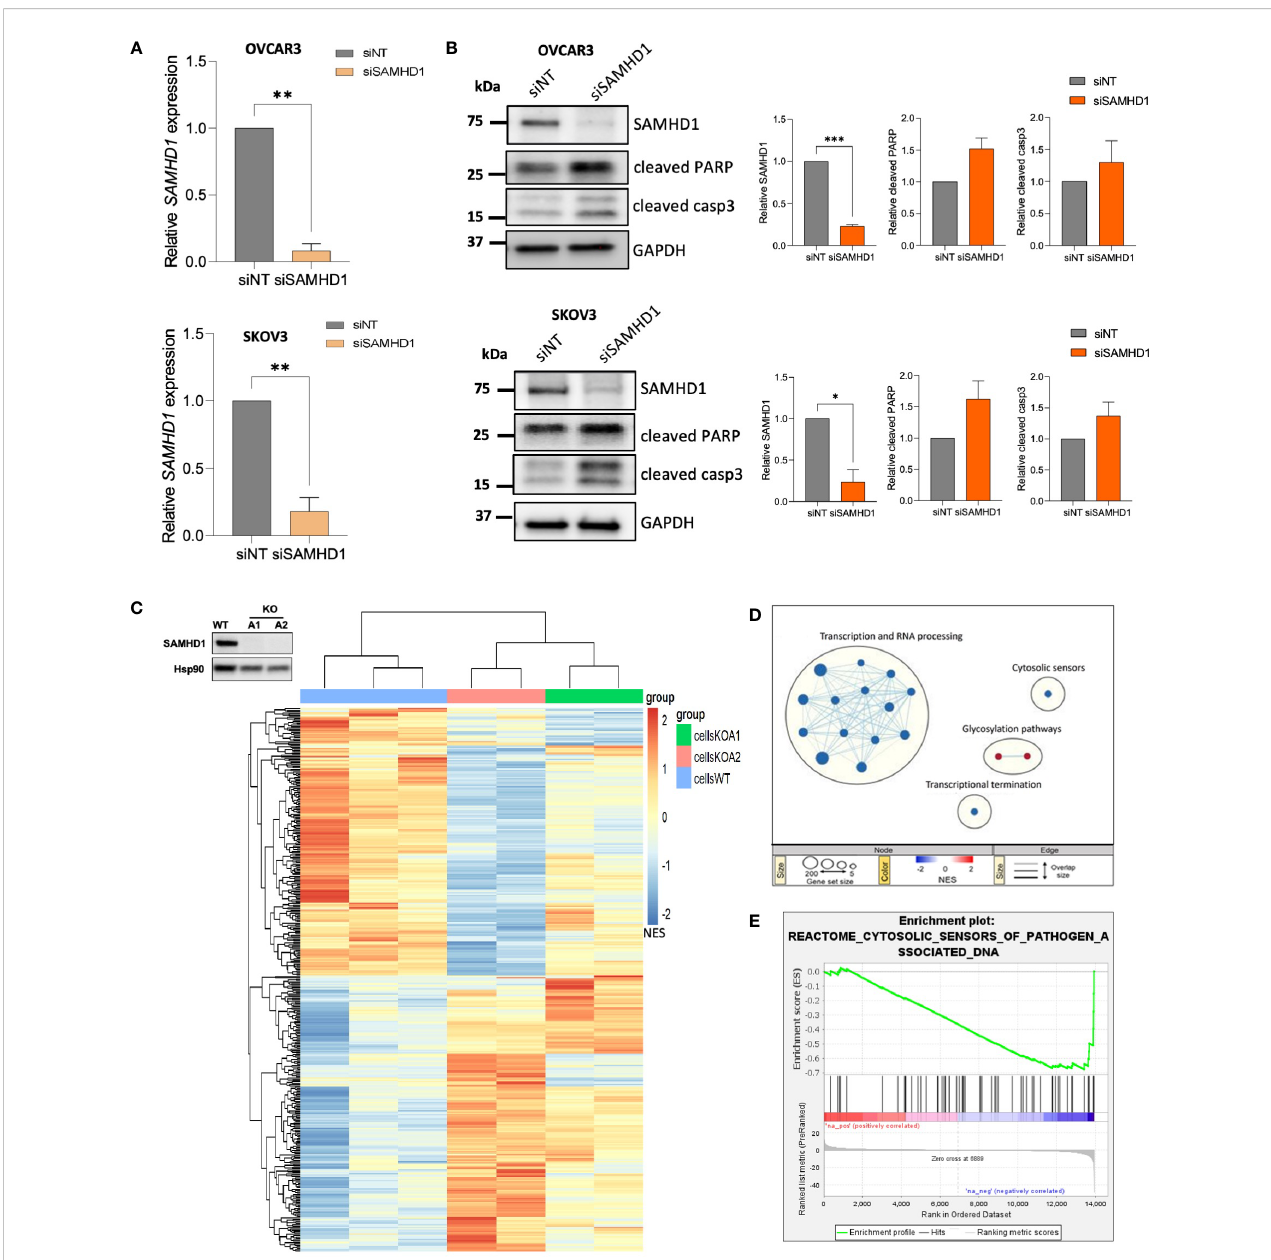
FIGURE 1 Depletion of SAMHD1 enhances apoptosis and regulates innate immune response. (A) Effective SAMHD1 downregulation by RNA interference in ovarian cancer cell lines. siRNAs targeting SAMHD1 gene (siSAMHD1) were transfected into SKOV3 cells (up) and OVCAR-3 cells (bottom). Gene expression was evaluated by RT-qPCR. (B) SAMHD1 knockdown induces apoptosis in ovarian cancer cells. Expression of apoptotic markers, cleaved PARP and cleaved Caspase 3 proteins, was measured by western blot in siRNA treated OVCAR3 (upper panel) and SKOV3 (bottom panel) cell lines. Representative western blot (left) and quanti fi cation (right) showing speci fi c siRNA-mediated inhibition of SAMHD1 and increased cleaved PARP and cleaved caspase 3 expression. (C) Heatmap representation of gene expression changes in SAMHD1-KO and SAMHD1-WT cells. Heatmap was generated by unsupervised hierarchical clustering of signi fi cantly expressed genes (normalized enrichment score NES; p < 0.05). (D) Reactome Gene set enrichment map of signi fi cantly enriched pathways for SAMHD1-KO cells. Reactome Gene set clusters are annotated, and nodes manually laid out for clarity. Node size represents number of genes, node color represents signi fi cance (NES), and edge thickness represents number of shared genes. (E) Enrichment plot of the reactome cytosolic sensors of pathogen associated DNA geneset. Pro fi le of the running ES Score of this geneset supports downregulation signature of cytosolic sensors and signalling pathways. Signi fi cantly down- or up-regulated genes (C) and gene sets (D) are highlighted in blue or red, respectively. * p <0.05; ** p <0.005; *** p